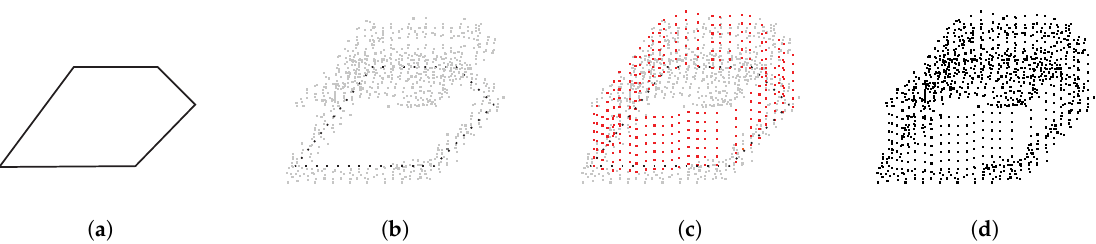
Figure 7. The process of adding points to building walls in the point-cloud using polygon shapes of walls: ( a ) building wall polygons are obtained from the cadastre data and aligned with the LiDAR data, ( b ) the polygon lines are split into segments according to the density parameter, ( c ) for each segment, we find the minimal and maximal height of the closest point cloud points and equidistantly add points in the vertical direction according to the density parameter, and ( d ) we add the generated points to the original point-cloud data.